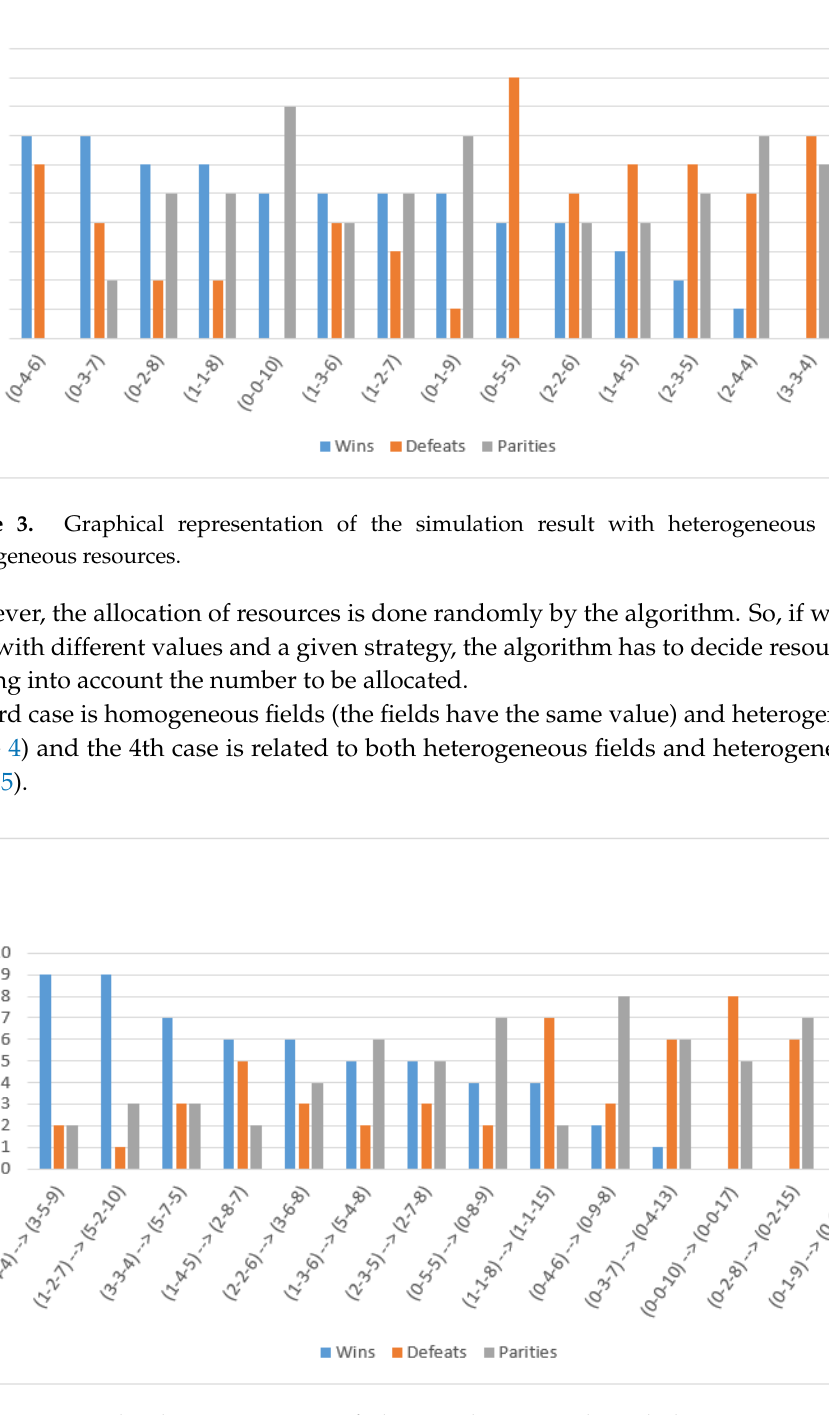
Figure 4. Graphical representation of the simulation result with homogeneous fields and heterogeneous